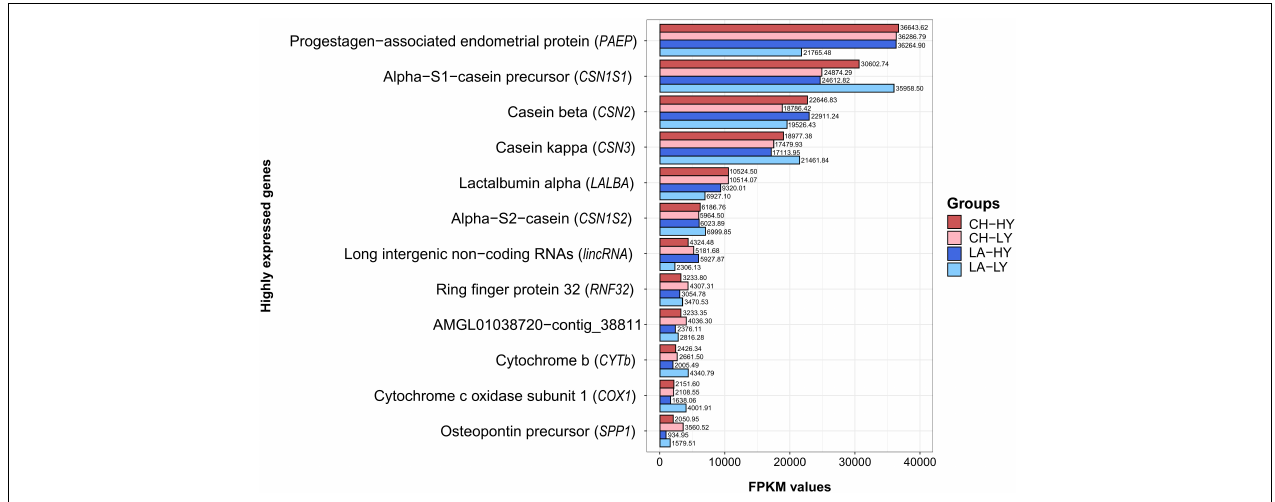
FIGURE 2 | Barplot of the highly expressed genes in milk somatic cells for each breed and group based on the average FMKP (Fragments Per Kilobase Million) values per group. CH, Chios; LA, Lacaune; HY, High yield; LY, Low Yield.